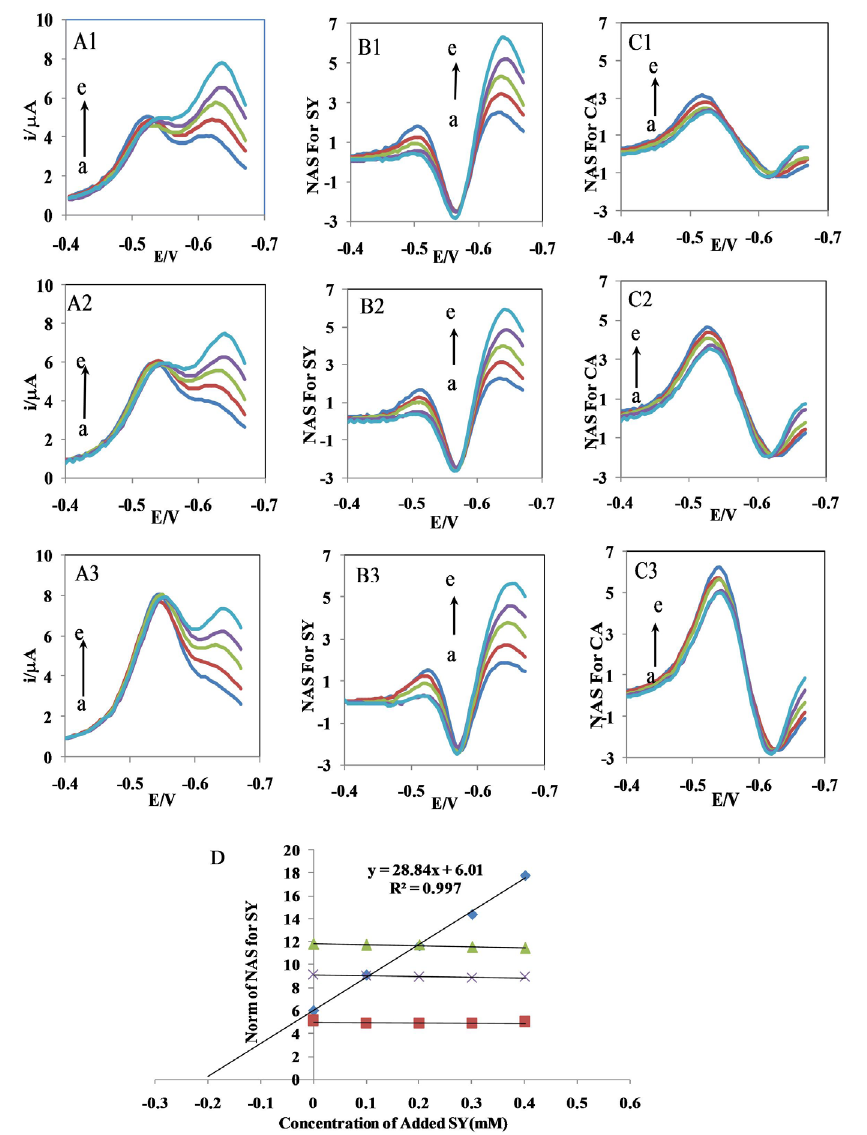
Figure 2. A1: (a) Voltammogram of SY (200 µM) and CA (200 µM) mixtures and after addition of (b) 100, (c) 200 and (d) 300 (e) 400 µM standard solutions of SY in constant concentration of CA (A1: 300, A2: 400 and A3: 600 µM). B1-B3: NASs curves for SY obtained from